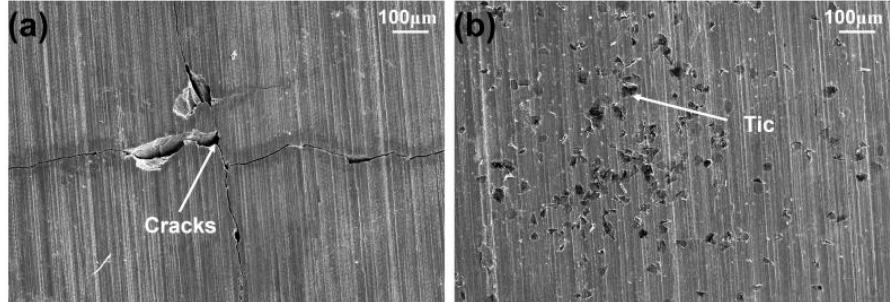
Figure 18. Surface topographies of LCC with Ni60/TC4 mass ratio of 2/8 (specimen No. 2). ( a ) Micro cracks; ( b ) Titanium carbide (TiC).